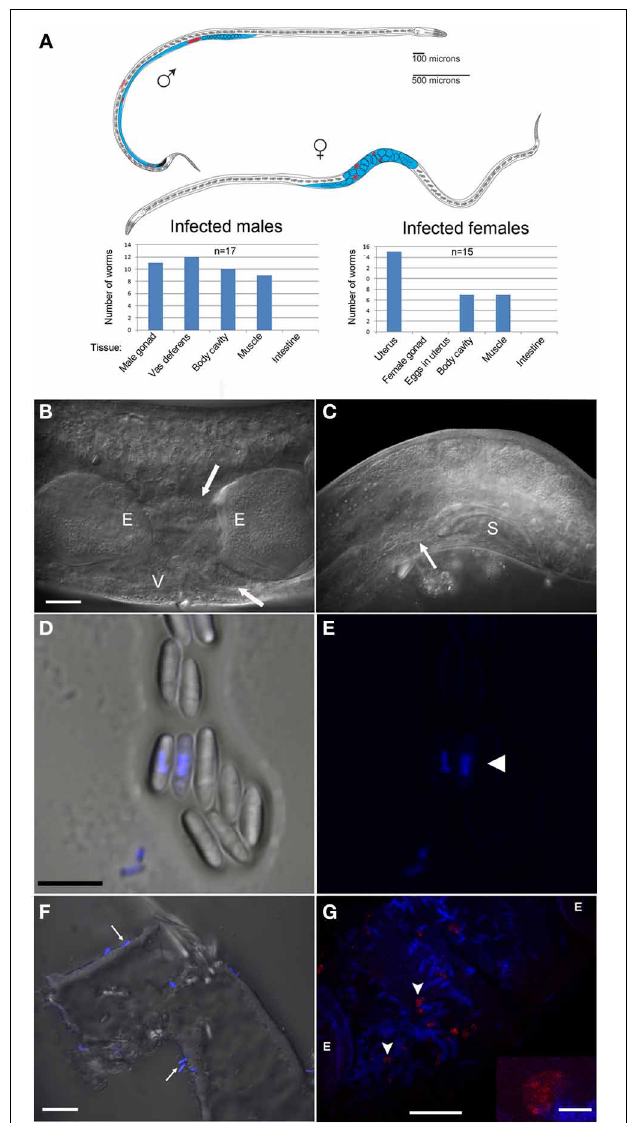
FIGURE 3 | N. marisprofundi is associated with D. marci reproductive organs. (A) A diagram of infected D. marci male and female. Gonads, male vas deferens, and female uterus are labeled in blue. Microsporidia spores are labeled in red. The bar graphs show the tissue-specific patterns of spore distribution in males and females, numbers are not exclusive. (B) Nomarski DIC of a moderately infected female. E, eggs; V, vulva; arrow, microsporidia spores. (C) N. marisprofundi infection of male reproductive organs. Microsporidia spores are distributed at the end of the vas deferens (arrow) and at the dorsal posterior side; S, male spicule; magnification as in B. (D) N. marisprofundi spores dissected from a female genital tract and stained by 4 (cid:2) ,6-diamidino-2-phenylindole (DAPI). (E) DAPI staining (blue) revealed nucleus-like structure inside the spores (arrowhead) magnification as in (D) . (F) Calcofluor white staining (blue) of N. marisprofundi spores (arrows) attached to a dissected worm cuticle. (G) In situ hybridization with N. marisprofundi SSU rRNA probe (red) and DAPI staining (blue) of an infected female fixed by paraformaldehyde to detect specifically the vegetative stages (see Materials and Methods section in Supporting Information). Vegetative stages (arrowheads) are positioned in the vicinity of spores. E developing embryo. Scale bars are 20 µ m (B,F,G) ; 5 µ m (D) ; insert 2.5 µ m (G)